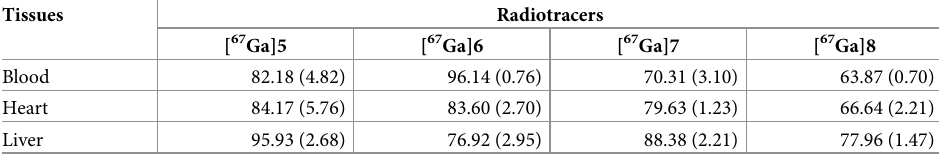
Data were presented as % of an intact form of [ 67 Ga] 5 , [ 67 Ga] 6 , [ 67 Ga] 7 , or [ 67 Ga] 8 determined by TLC. Each value represents mean (SD) for three